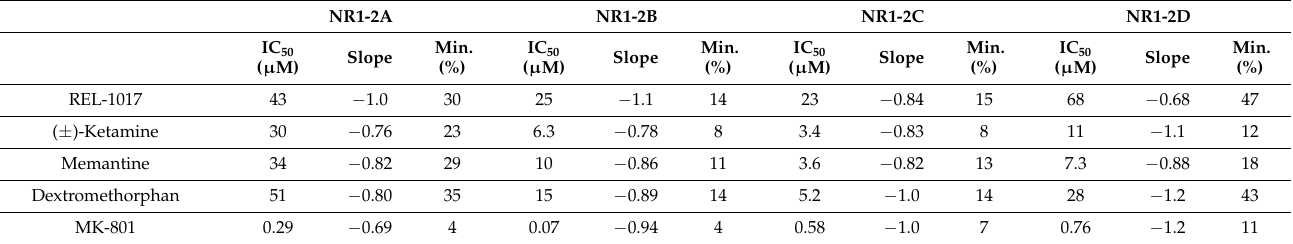
Table 1. IC 50 values of REL-1017 and reference NMDAR blockers.